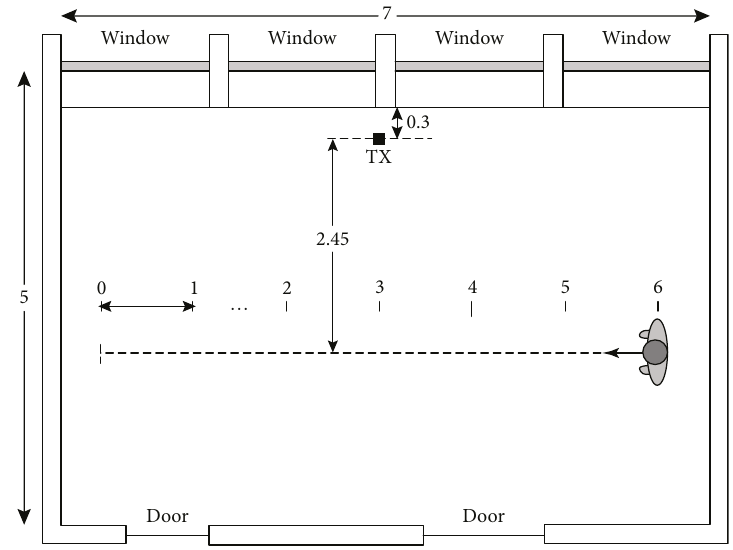
Figure 2: Layout of the investigated indoor environment (dimensions are in meters). Table 1: Positions of RX antennas for di ff erent space diversity con fi